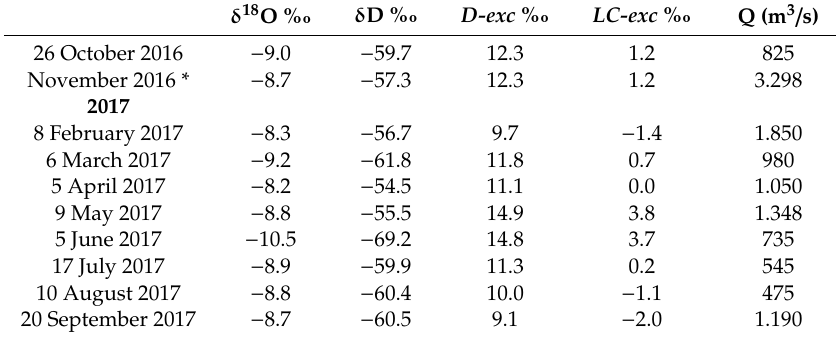
Table 2. Hydrogen and oxygen isotopic composition of Po river water at the Pontelagoscuro (Plg in Figure 1) closing section in the hydrological year 2016–2017; D-exc and LC-exc and Po river discharge (data from ARPA Veneto) are also reported. The value of November 2016 represents an average value of 4 samples collected between the 18 November 2016 and 29 November